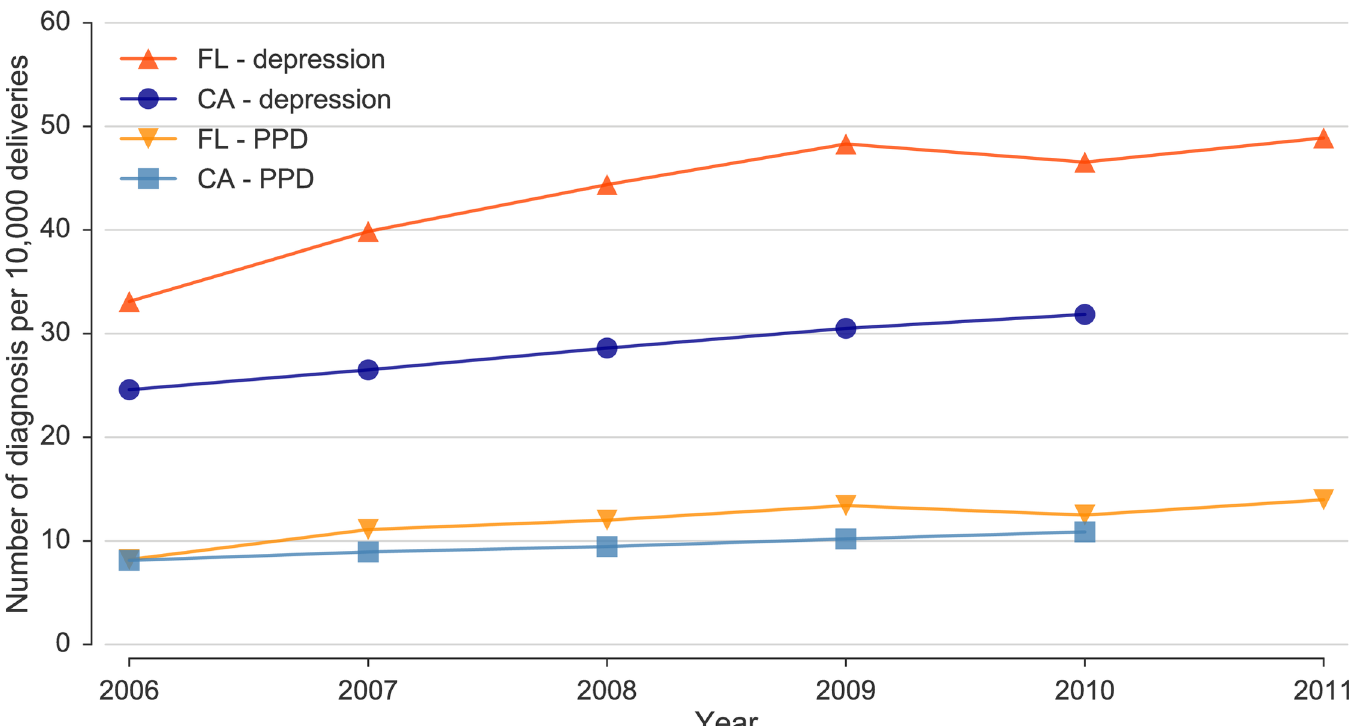
Fig 1. Temporal trends for all depression and PPD diagnoses per 10,000 deliveries for California (p < 0.01 for both trends) and Florida (p < 0.02 for both